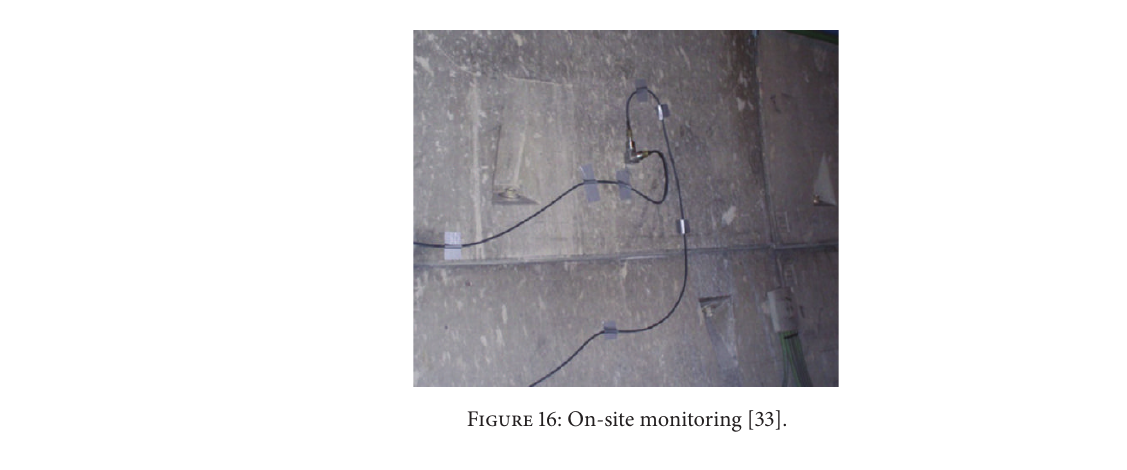
Figure 15: Von Mises stress envelope curve (unit: kPa).